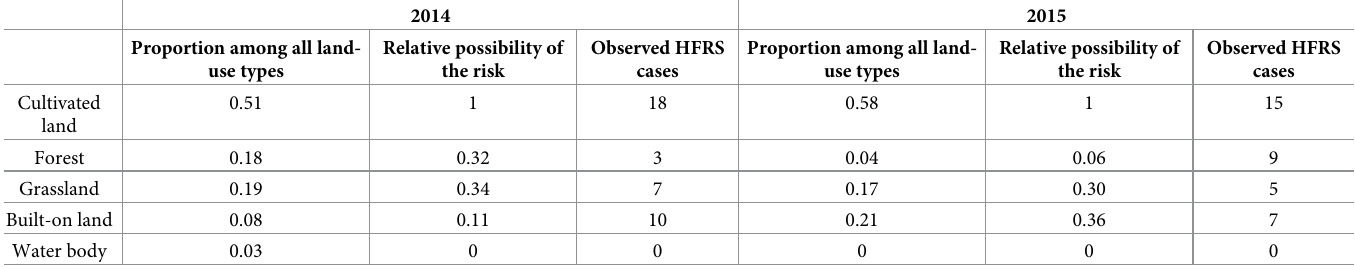
Table 3. Predicted proportions and relative possibility of HFRS incidence risk and the number of observed HFRS cases among the different land-use types in 2014 and 2015. (On-diagonal data to predict the off-diagonal